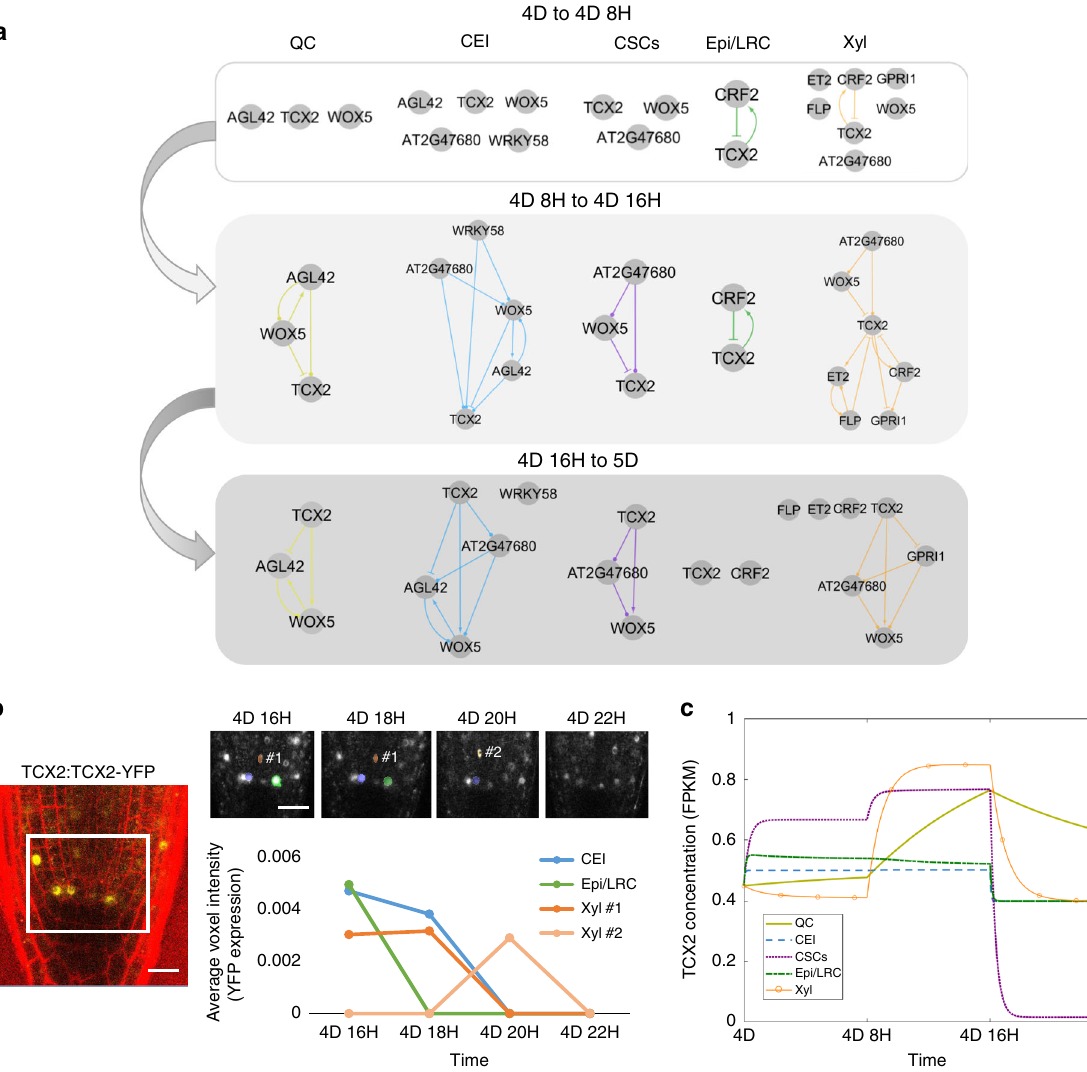
Fig. 4 Mathematical modeling of TCX2 network predicts timing of cell division. a TCX2 fi rst-neighbor TF networks predicted using RTP-STAR on the stem cell time course for 4 day (4D) to 4 days 8 h (4D 8H) (top), 4D 8H to 4D 16H (middle), and 4D 16H to 5D (bottom). Networks are separated based on the cell type the genes are expressed in: QC (yellow), CEI (blue), CSCs (purple), Epi/LRC (green), Xyl (orange). Arrows represent predicted activation, bars inferred repression, and circles no inferred sign. b (left) Representative image of TCX2:TCX2-YFP at 4D 16H. White box represents the stem cell niche were cells were tracked over time. Scale bar = 20 µ m. (right, top) YFP-positive cells tracked every 2 h from 4D 16H (left) to 4D 20H (right). Stem cells that were tracked are marked in blue (CEI), green (Epi/LRC), and orange (Xyl). Two Xyl cells were tracked, #1 and #2. All of these four stem cells had no measurable YFP expression at 4D 22H. (right,bottom) Quanti fi cation of YFP expression in tracked cells. c ODE model prediction of cell-speci fi c TCX2 expression from 4D to 5D. FPKM: fragments per kilobase per million mapped